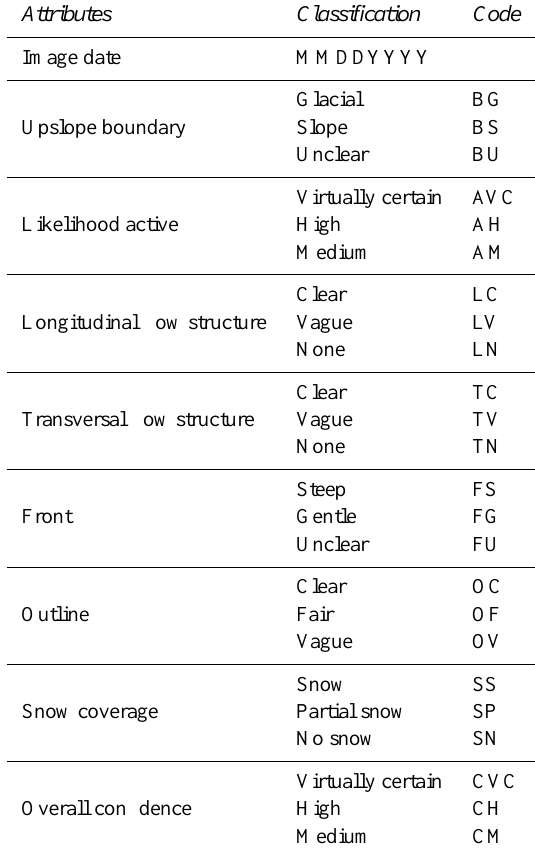
Table 1. Attributes derived during rock glacier mapping. They are recorded in the description field of each rock glacier outline as de- scribed in the supplement to this